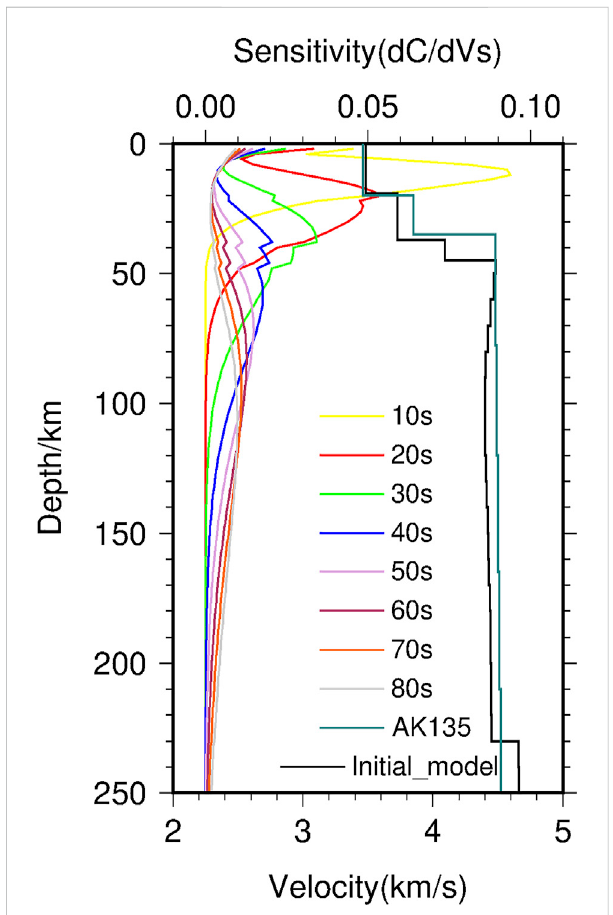
FIGURE 6 Depth sensitivity kernels of Rayleigh-wave phase velocity at different periods. The black line represents the initial model for calculating the depth sensitivity kernels, which is the model retrieved by using the mean value of the dispersion curve in the study area (the red curve in Figure 3).